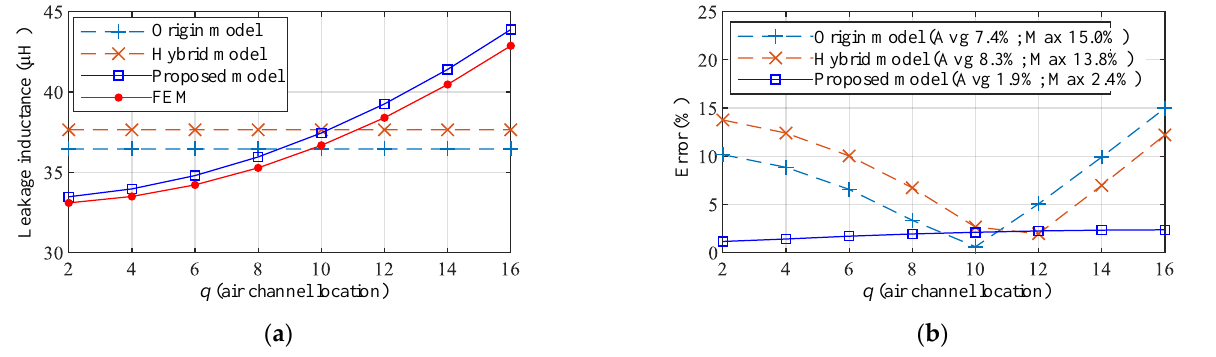
Figure 10. Comparison of FEM and analytical calculation results. ( a ) Comparison of results, ( b ) Comparison of errors.